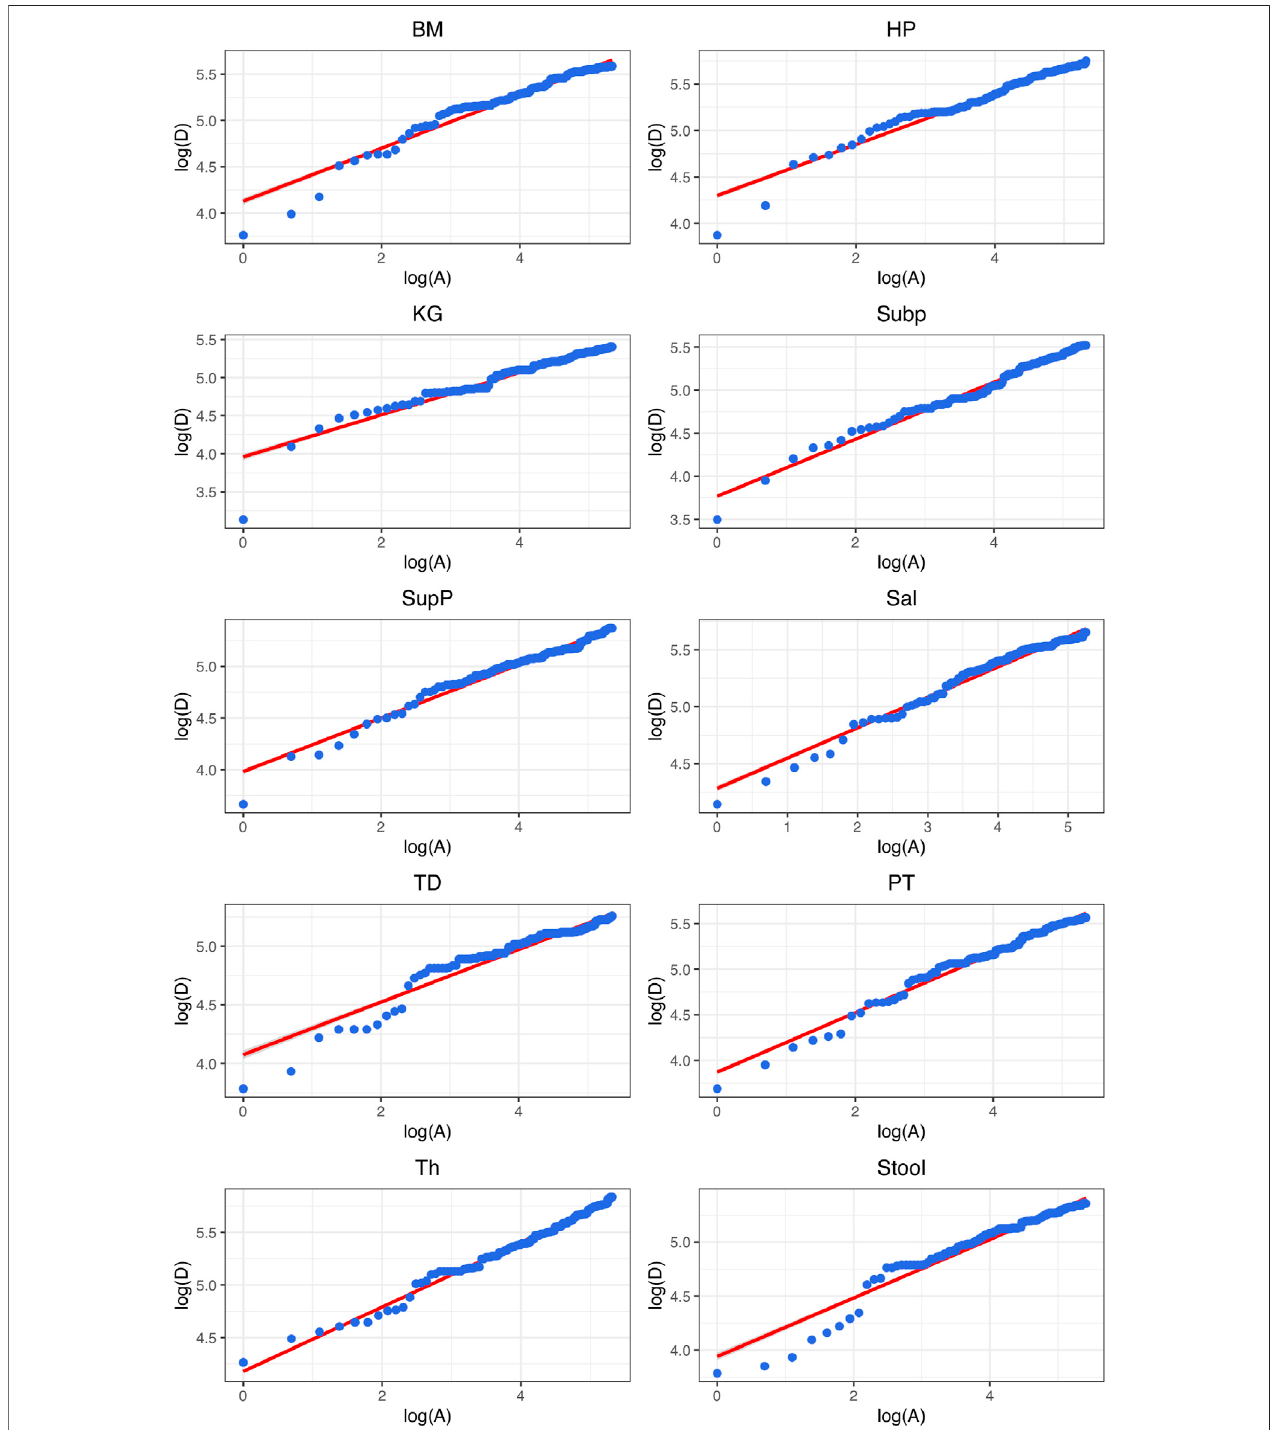
FIGURE 3 | Graphs of fi tting the diversity-area relationship (DAR) power-law (PL) model ( Eq. 5 ) for the gut microbiome at each of the 10 DT (digestive tract) site, at the genus taxon level, for diversity order q (cid:1) 0 ( i.e ., species richness).